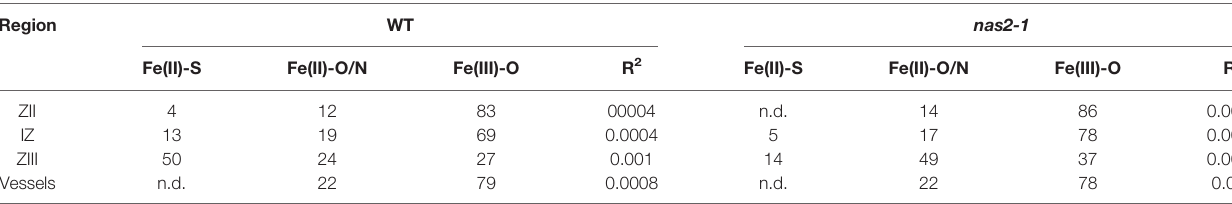
TABLE 1 | Iron speciation (%) in wild type (WT) and nas2-1 nodules. n.d., not detected. Region